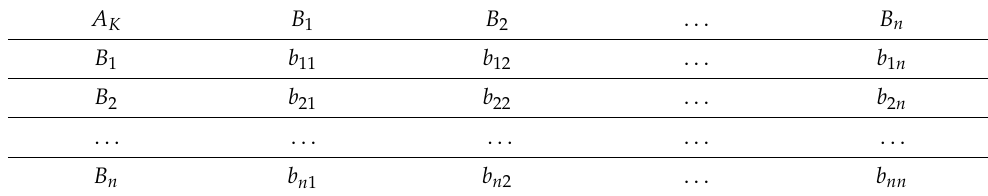
Table 3. Structure of the judgment matrix.